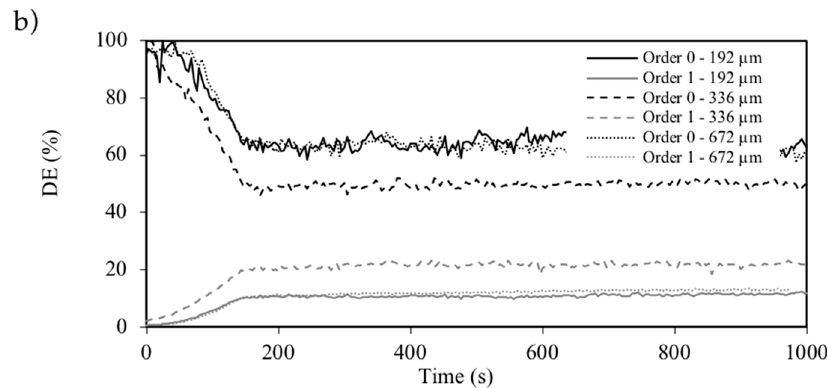
Figure 5. ( a ) DE of zero and first orders as a function of time for an exposure of a 720 µm sinusoidal grating over 50, 100 and 150 s and the post-evolution. ( b ) DE of zero and first orders as a function of time for an exposure of 192, 336 and 672 µm sinusoidal gratings during 150 s and the post-evolution.